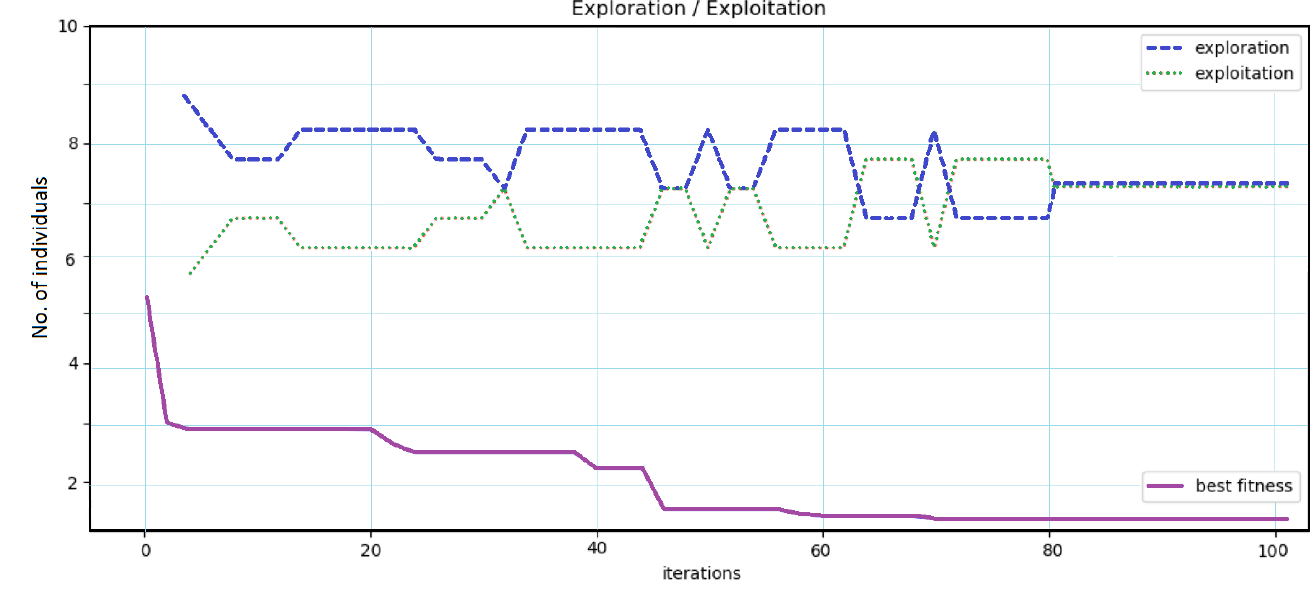
Figure 4. The exploration exploitation balance during the optimization process.